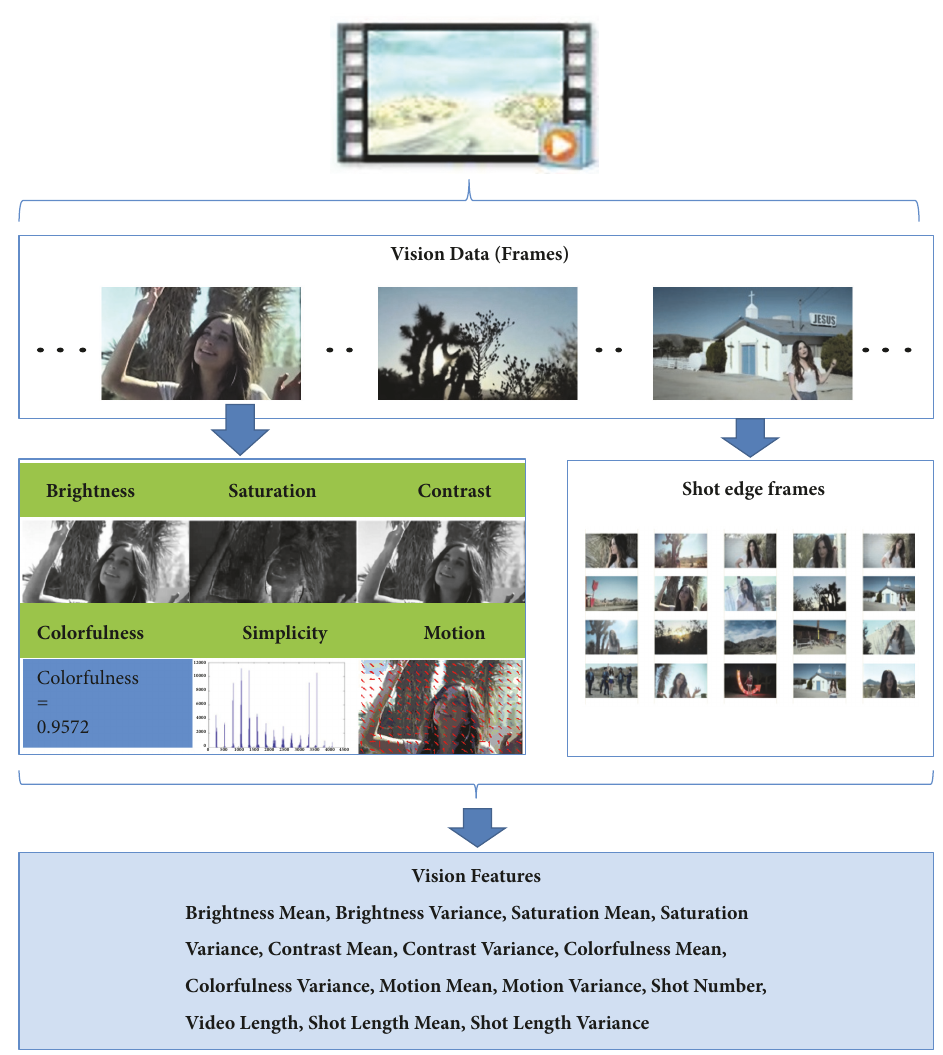
Figure 1: Video features extraction